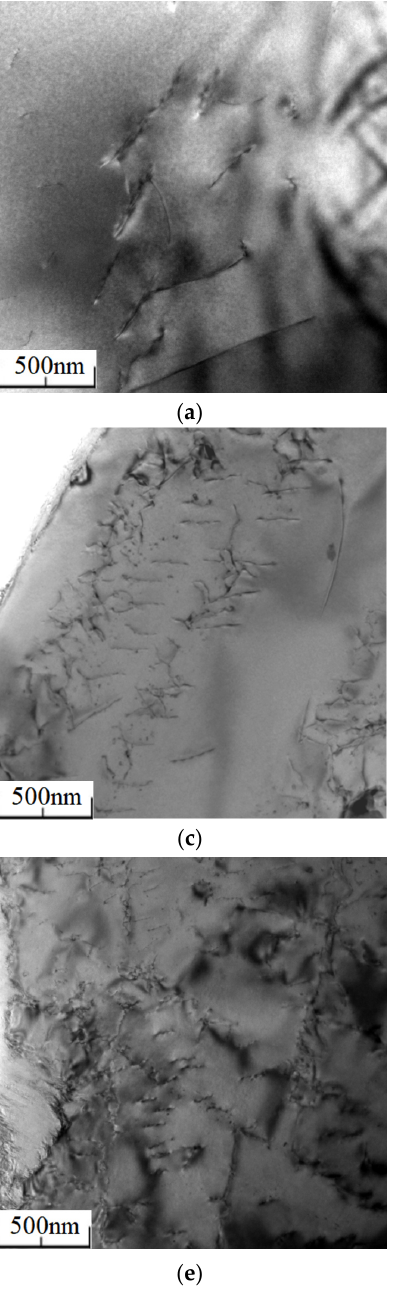
Figure 9. The microstructure of the α phase after low cycle fatigue deformation under different total strain amplitudes: ( a ) initial state; ( b ) Δ ε t = 1.4%, N f = 7988 cycles; ( c ) Δ ε t = 1.6%, N f = 3200 cycles; ( d ) the dislocation pile ‐ up at Δ ε t = 1.6%, N f = 3200 cycles; ( e ) multiple dislocations at Δ ε t = 1.8%, N f = 1731 cycles; ( f ) the shear of β phase at Δ ε t = 2.0%, N f = 1302 cycles.